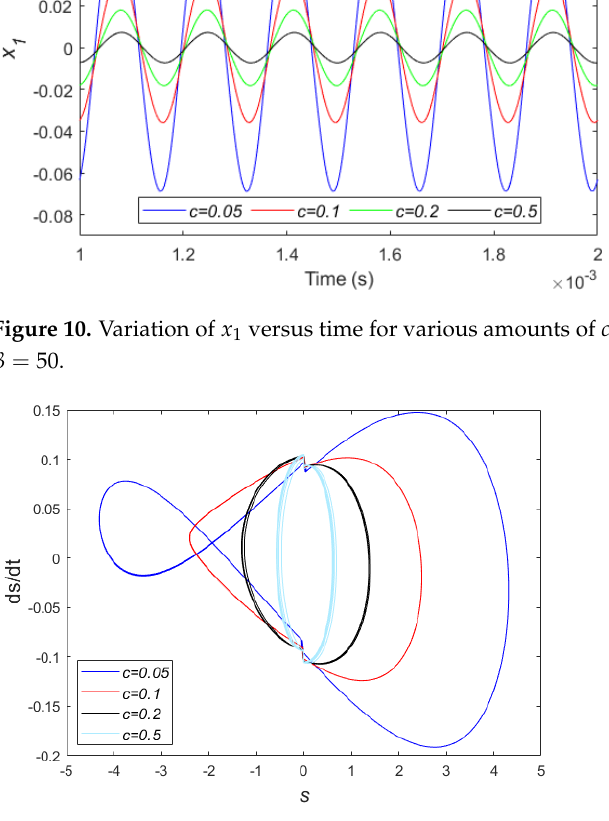
Figure 11. The phase portrait of manifold s and s 19 p = q = 17, and β =